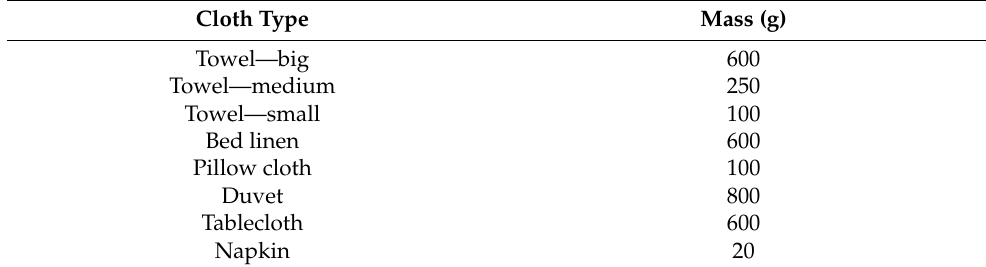
Table 10. Reference weight of most common clothes used by hotel guests. Cloth Type